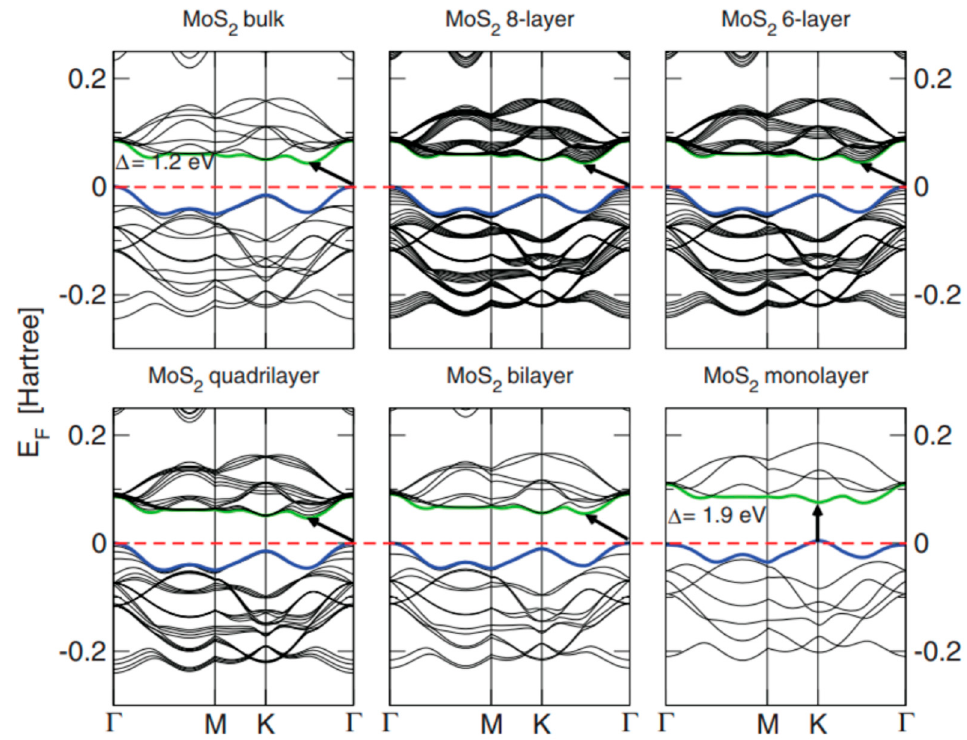
Figure 4. Electronic band structure of MoS 2 from bulk to monolayer. Reproduced with permission from [26]. © American Physical Society, 2011.